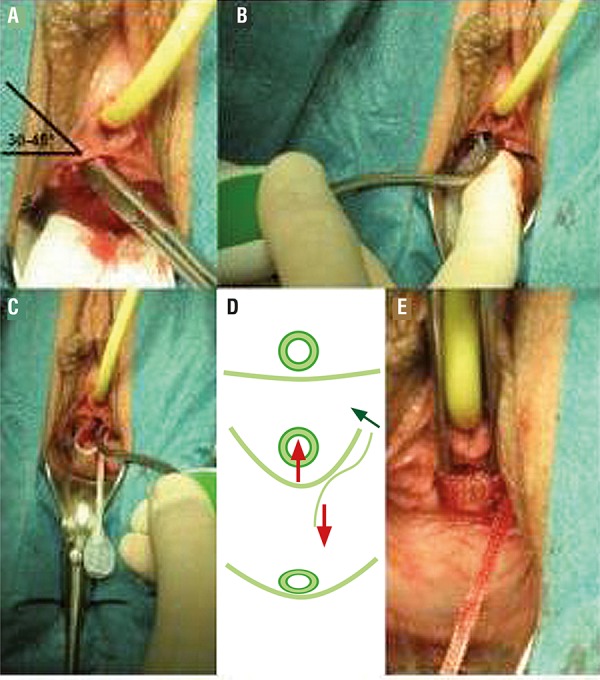
A) A bilateral small tunnel towards the inner margin of the inferior ramus pubis is created; B) Firstly the introducer is gently forwarded through the tunnel until the right obturator membrane is fully perforated (2 steps of resistance); C) The contralateral obturator membrane is perforated. The introducer shape is helpful in preventing a too deep insertion; D, E) A gentle tightening of the sling follows until no further leakage occurs through the Valsalva manoeuvre with 300cc bladder filling.